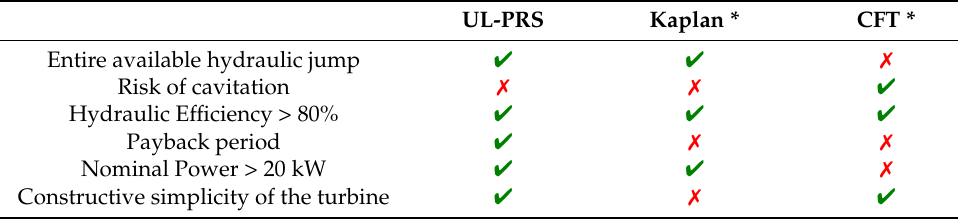
Table 5. Benefit comparison of solutions.